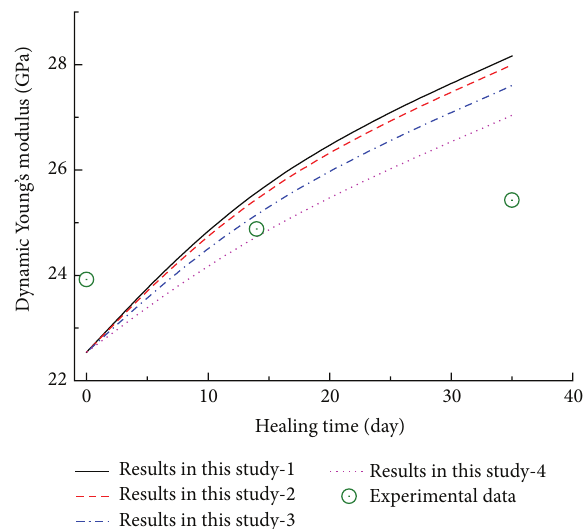
Figure 7: Comparison between the results obtained with the proposed model and those obtained experimentally [14] for the dynamic Young modulus in the dry state, with 1, 2, 3, and 4 representing results obtained with the first, second, third, and fourth types of ITZ.